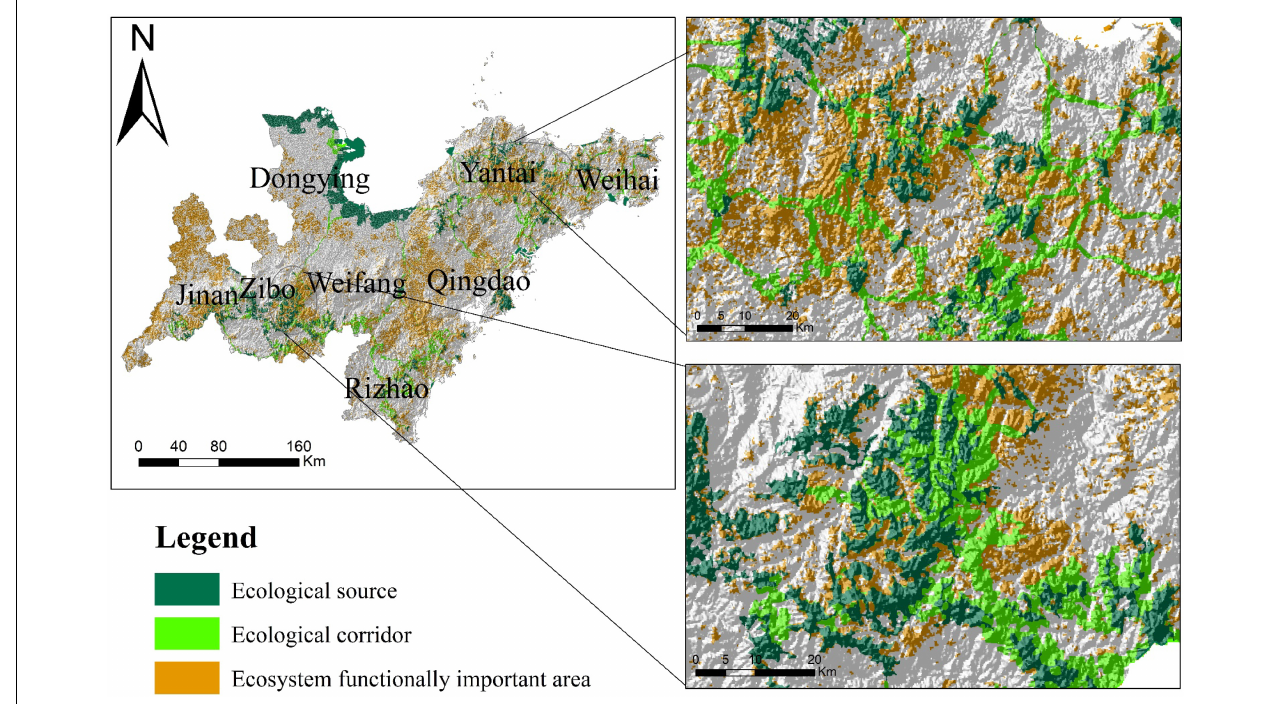
FIGURE 12 | Spatial overlap of ENs and ecosystem functionally important